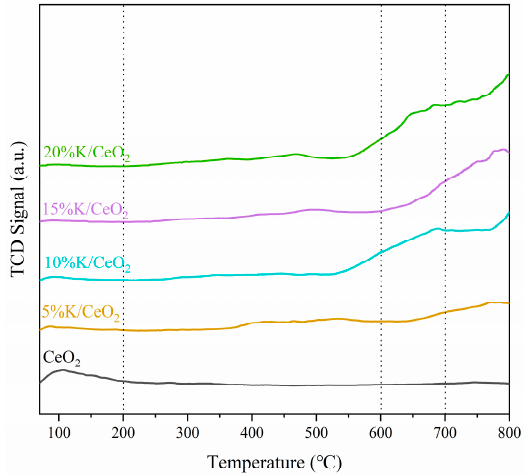
Figure 5. CO 2 -TPD with di ff erent ratios of K surface modi fi ed CeO 2 .